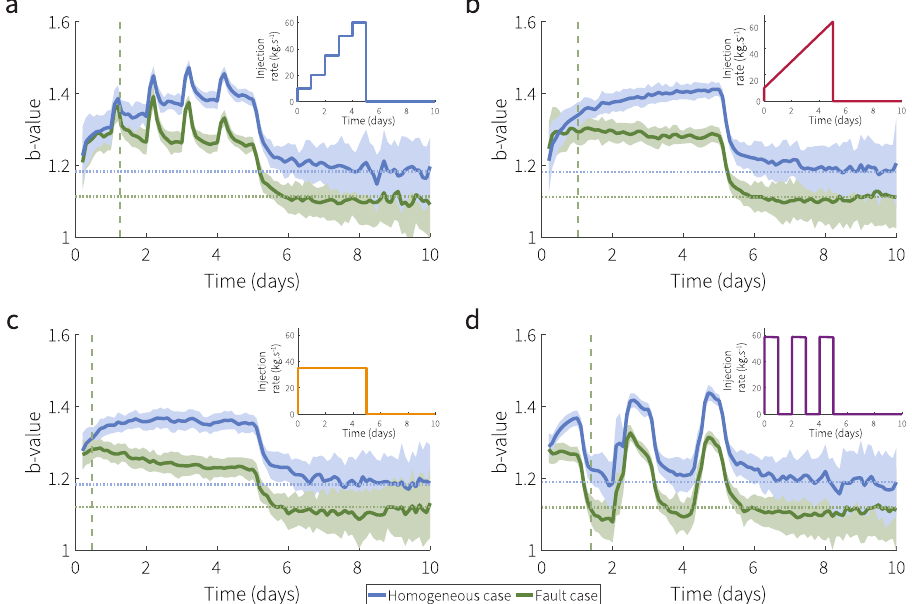
Fig. 5 Transient b -value for different injection strategies. For each panel, blue is the homogeneous case and green the fault case, the shaded areas show a ± one standard deviation interval, the horizontal dashed lines denote the intrinsic (i.e. at rest) b -value, and the vertical dashed lines show the earliest trigger on the fault. a Step increasing; b Linearly increasing; c Constant; d